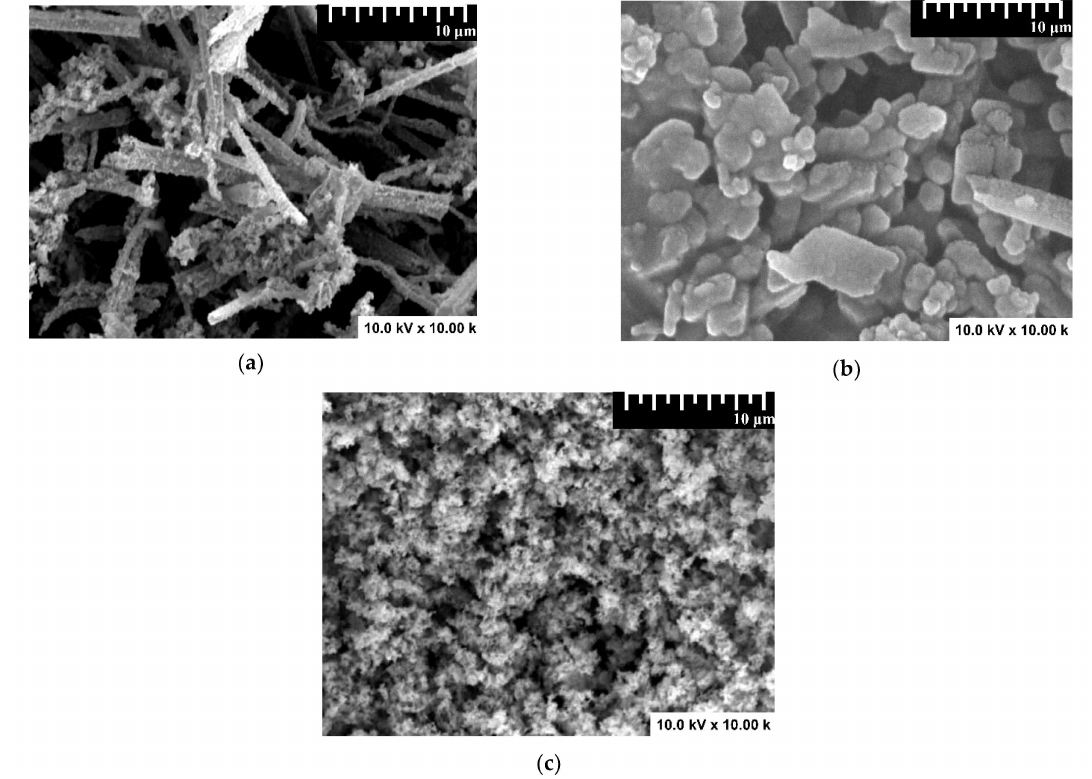
Figure 3. SEM images of ( a ) WO 3 , ( b ) SnO 2 /WO 3 , and ( c ) Cu 2 O/SnO 2 /WO 3 samples. Table 2. Photocatalyst elemental composition by EDX.